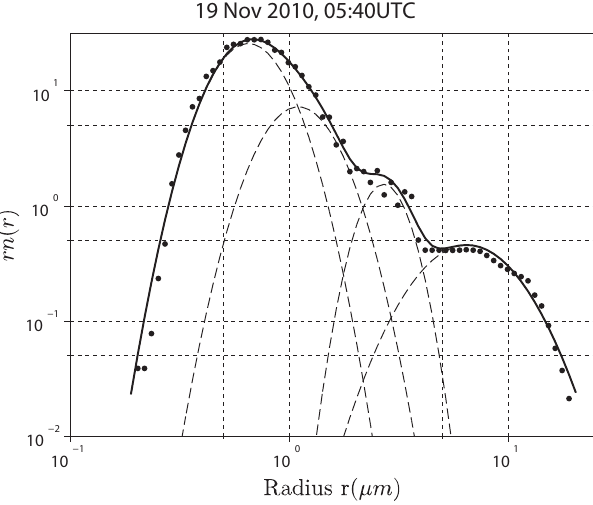
Fig. 1. Composite size distribution measured by Welas 2000 and FM100 on 19 November 2010, at 05:40UTC. The measurements are the dots. A sum of M = 4 log-normal modes are fitted. Each mode is represented by dashes. The sum fitted to the measurements is the thick, solid line. The parameters of the modes are given in Table 1 (fog case